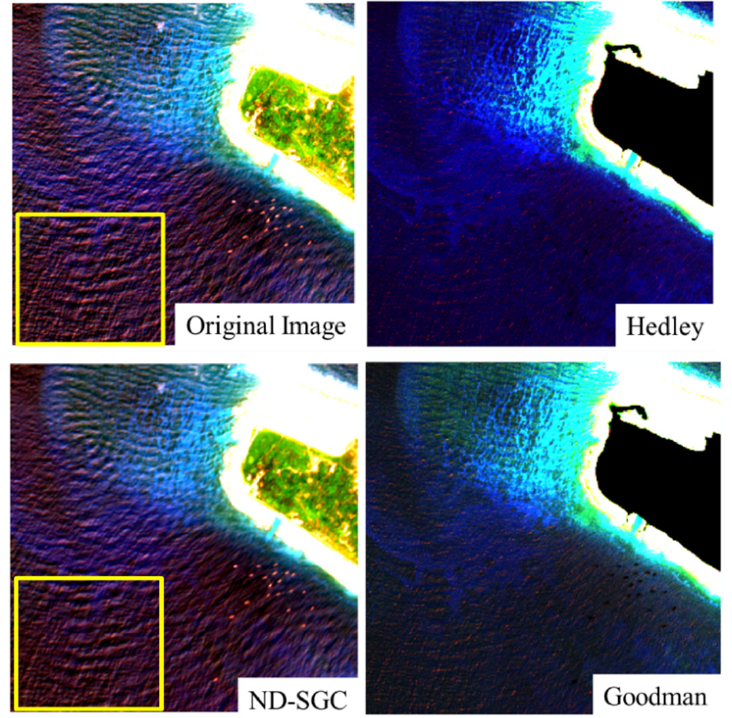
Figure 14. Results of different sun glint correction methods.